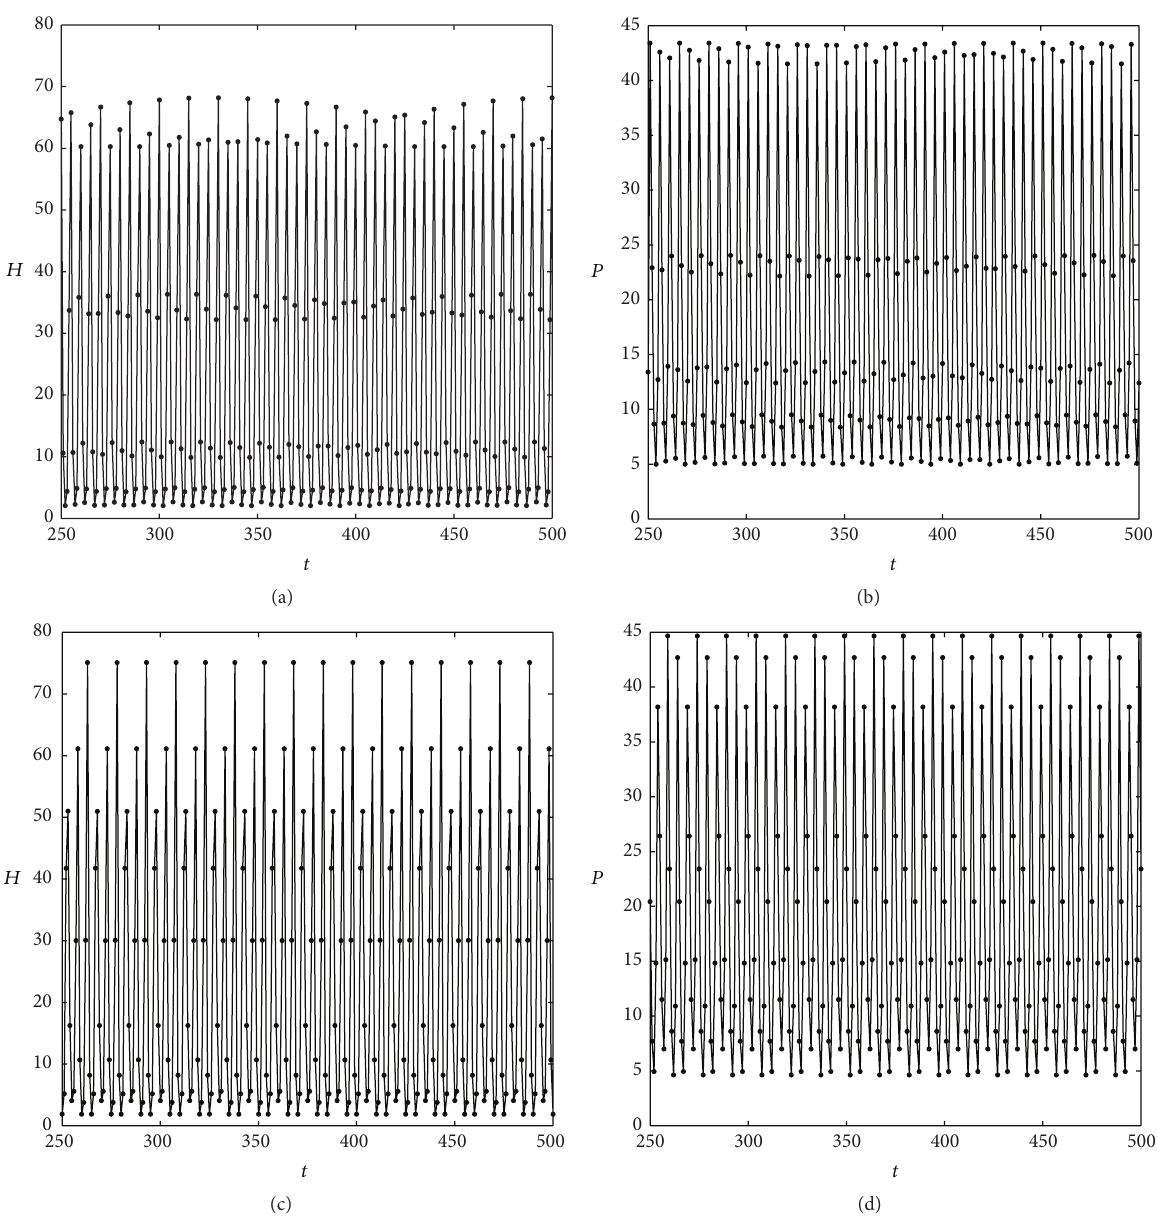
Figure 7: Two attractors’ coexistence. The parameter values are as follows: 𝑇 = 10 , 𝑇 ℎ = 0.5 , 𝐾 = 50 , 𝛿 = 0.3 , 𝛾 = 1 , 𝛼 = 0.01 , 𝜃 = 0 , 𝑞 = 0.05 , and 𝑟 = 3.2 . The initial values are (5,5) for (a-b) and (2, 1) for (c-d).